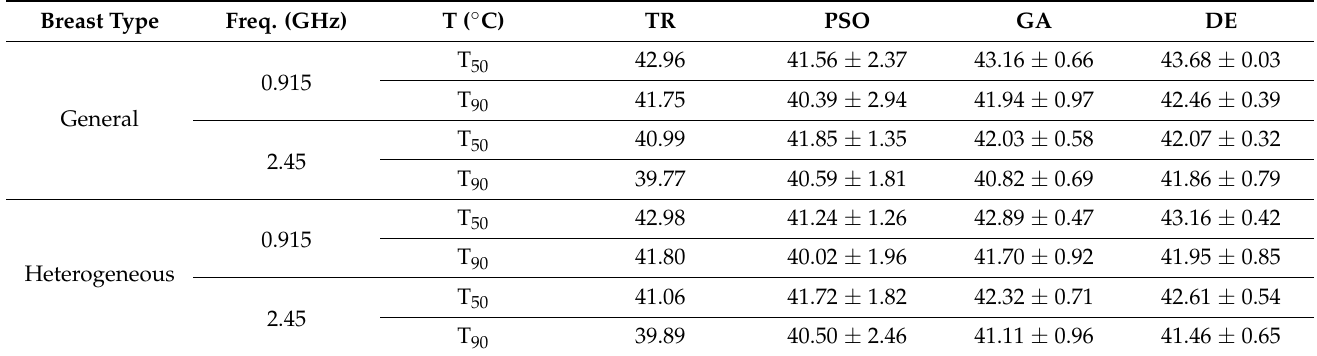
Table 3. Mean and standard deviation of T 50 and T 90 values for two breast models using HTP optimization methods.